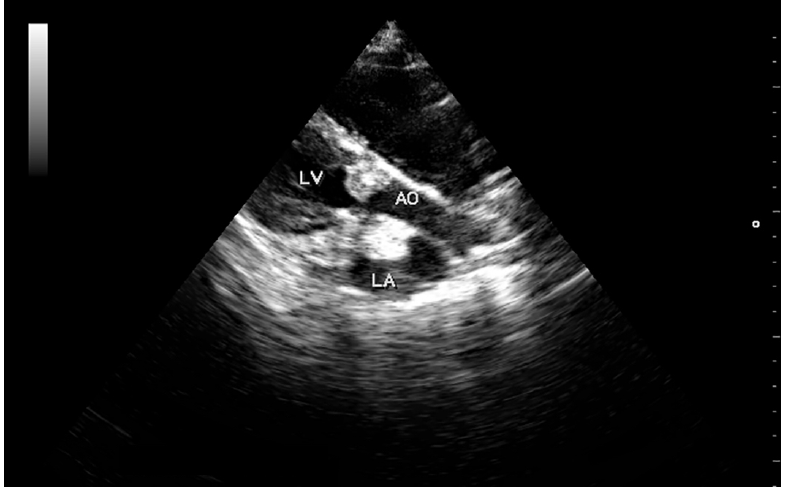
Figure 2. Right parasternal longitudinal view of the left ventricular outflow tract showing large vegetations over an aortic valve cusp and above the mitral valve protruding into the left atrium. Abbreviations: LV, left ventricle; AO, aorta; LA, left atrium.